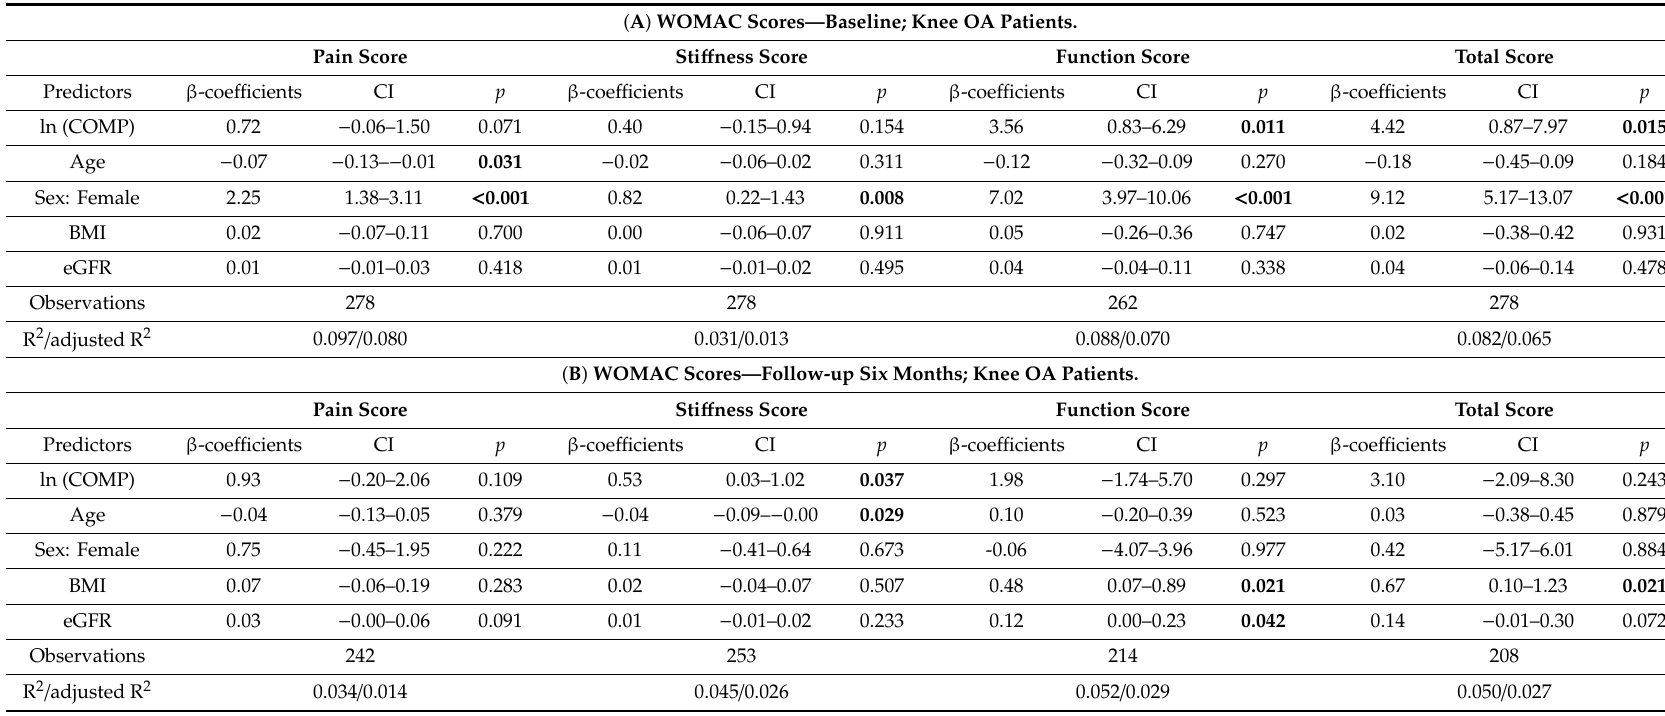
Table 4. WOMAC Scores of patients with knee OA. (A) Baseline and (B) follow-up six months after surgery. Multiple linear regression models adjusted for age, sex, BMI, and eGFR. Significant associations are highlighted in